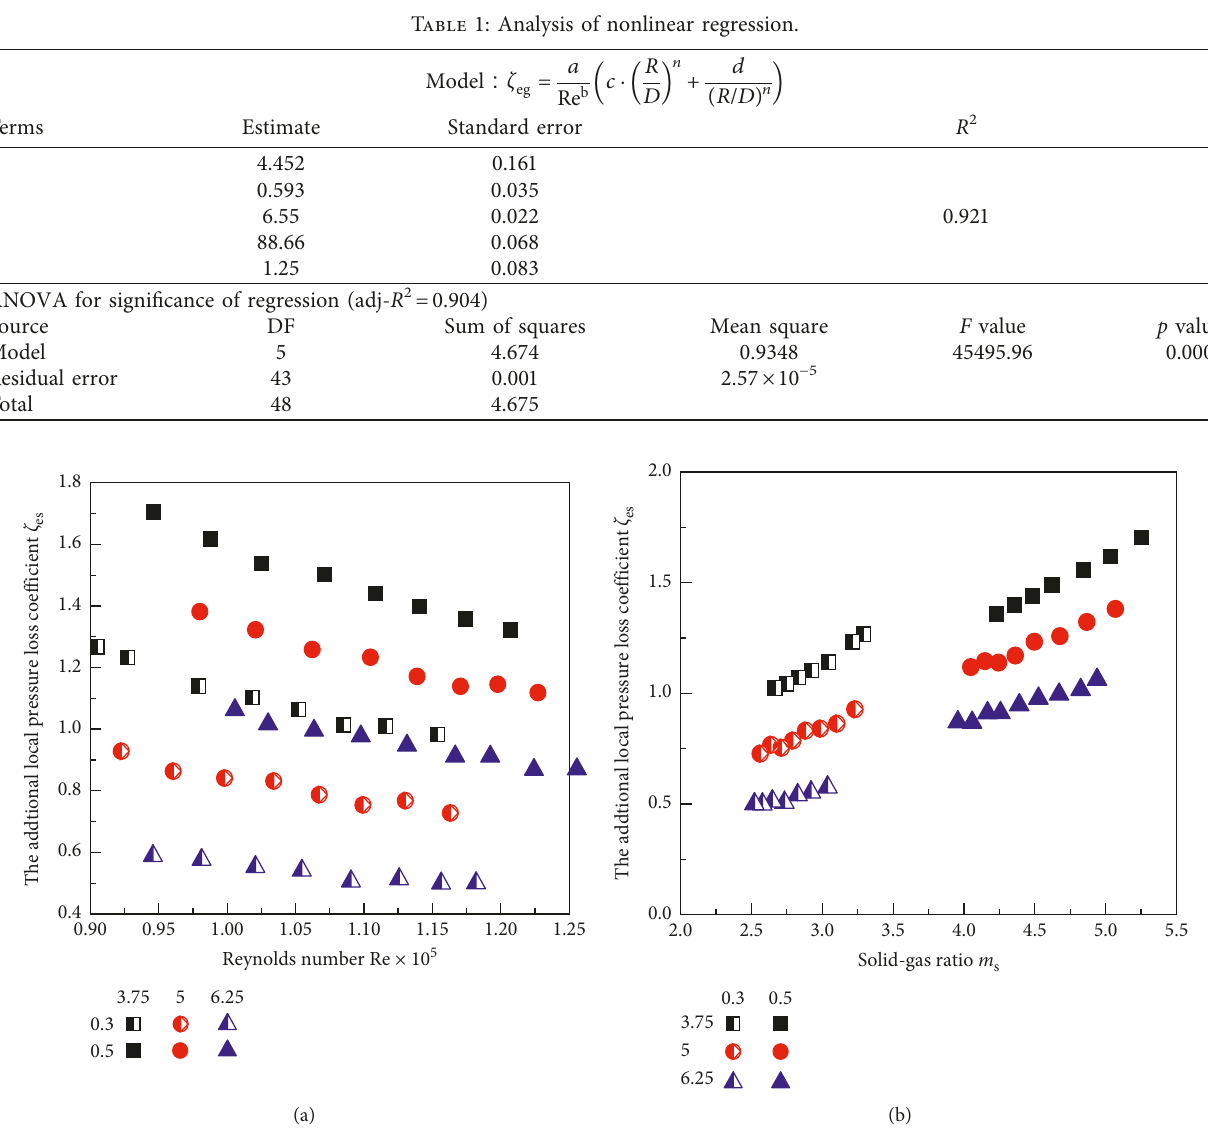
Figure 9: Relationships between the additional pressure loss coefficient of solid flow and (a) Reynolds number and (b) solid-gas